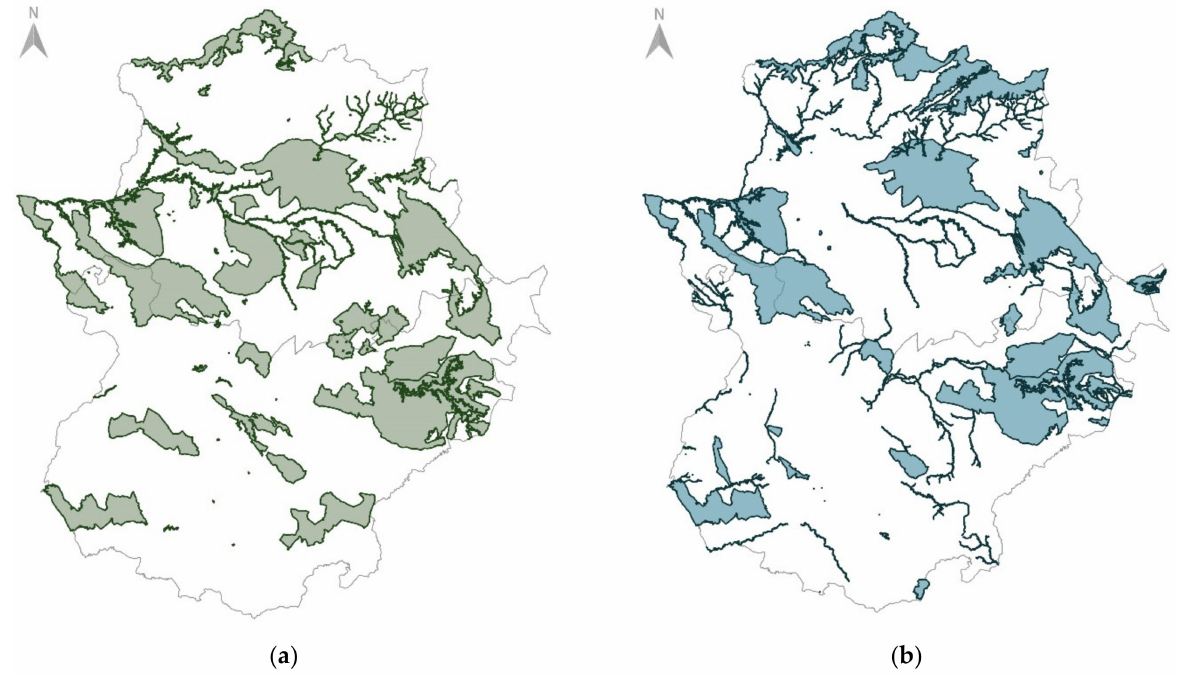
Figure 4. Spatial distribution of protected areas of the Natura 2000 network in Extremadura (Spain): ( a ) SPAs and ( b ) SACs [55].